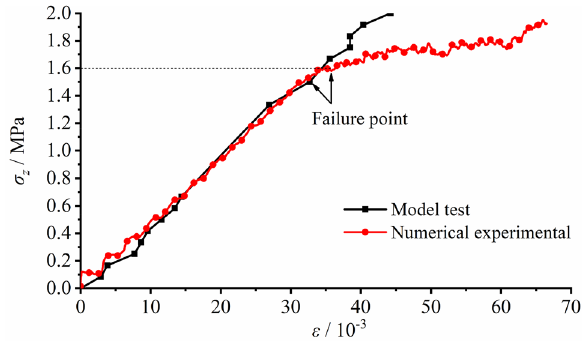
Figure 19. Comparison of load − deformation correlations between laboratory and numerical loading testing.